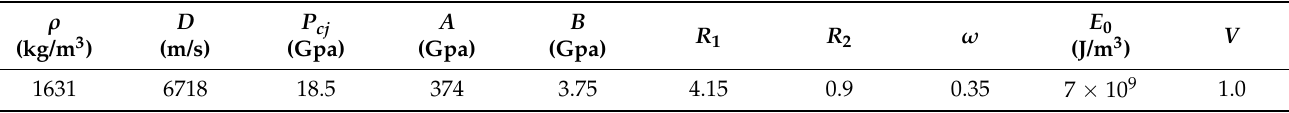
Table 3. Parameters of TNT and equation of state parameters.